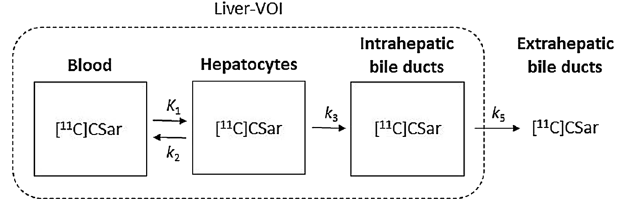
Figure 6. Kinetic two-tissue compartmental model of transport of [ 11 C]CSar from blood to bile. K 1 : unidirectional clearance from blood to hepatocytes (mL blood/min/mL liver tissue); k 2 : rate constant for backflux from hepatocytes to blood (/min); k 3 : rate constant for secretion from hepatocytes to intrahepatic bile ducts (/min); k 5 : rate constant for bile flow out of the liver (/min). Liver-VOI liver volume-of-interest